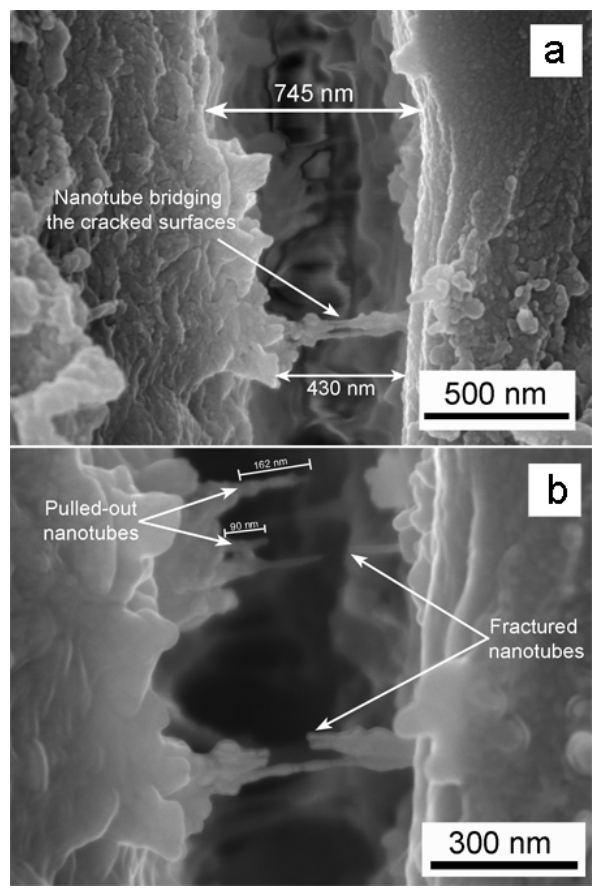
Figure 12. PC/TiO 2 -0.05HN fractography at high magnification: ( a ) A crack opening revealing crack bridging by the TiO 2 nanosheets and nanotubes; ( b ) TiO 2 NT pullout during electron beam scanning of a small area inside a crack.